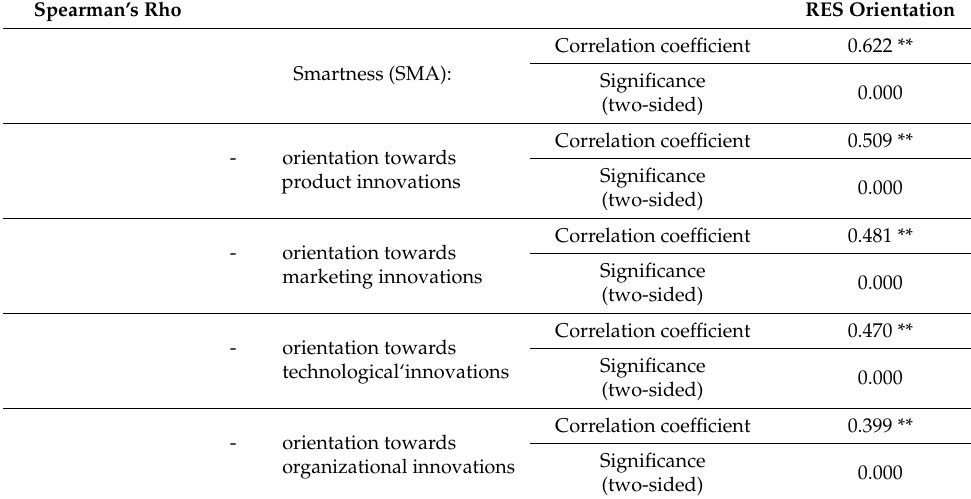
Table 6. Correlation between SMA and RES orientation ( n